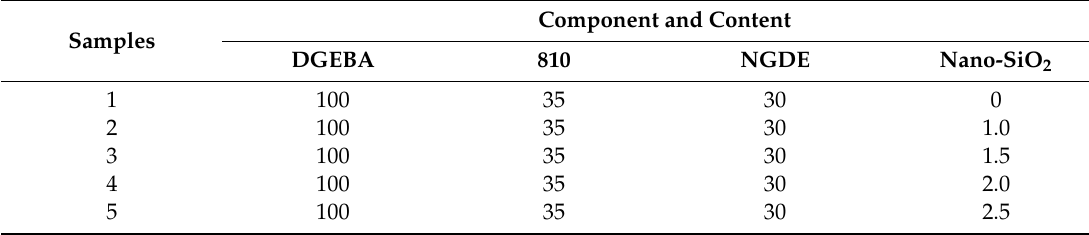
Table 1. Weight parts of each materials in phenolic amine / epoxy resin system for tensile performance